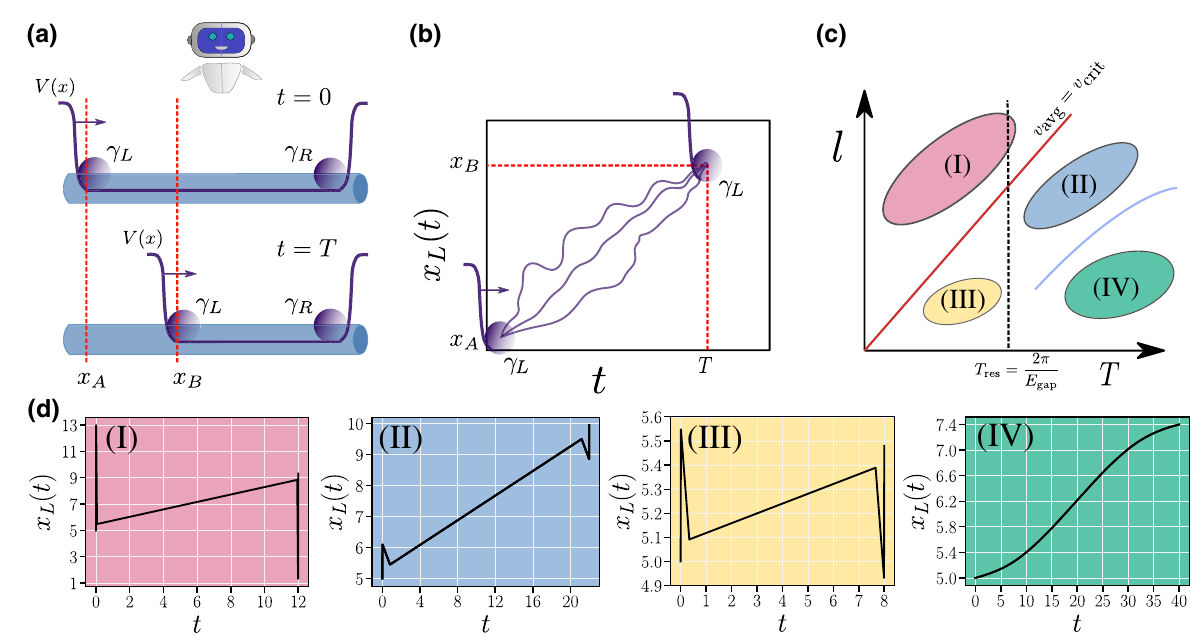
FIG. 1. (a) In the Majorana game, the agent moves the left Majorana γ L from a position x A to a position x B by tuning the external potential profile V ( x , t ) . (b) The agent attempts different movement paths and tries to find the optimal one that minimizes the infidelity I ( T ) . (c) Different Majorana control regimes and their corresponding strategies [boxes in (d)]: (I) critical regime ( v subcritical regime ( v crit / 2 < v avg < v crit ), (III) short time T , low-velocity regime, and (IV) (super)adiabatic regime (long time T